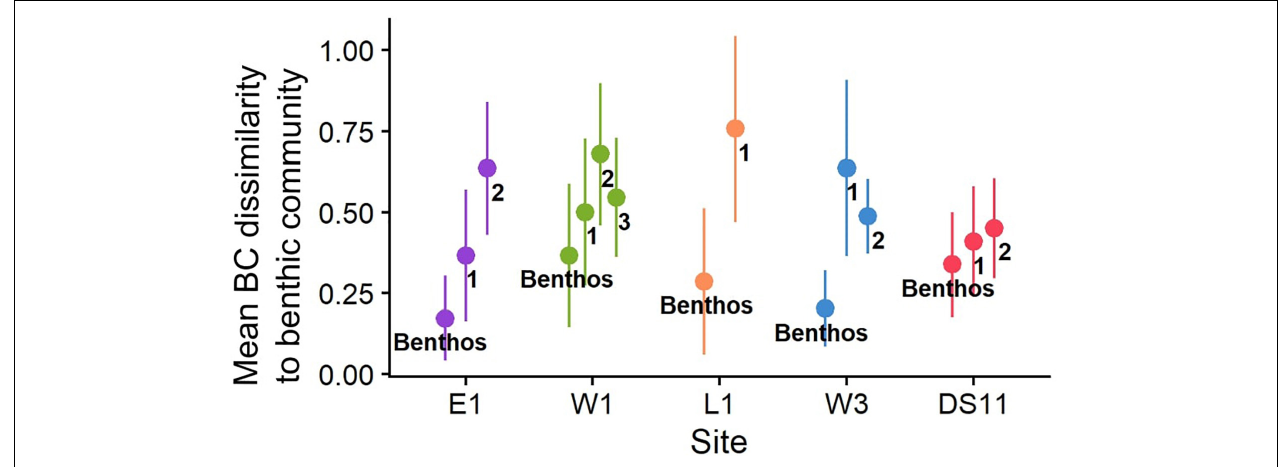
FIGURE 7 | Mean Bray-Curtis (BC) dissimilarity within the established benthic community (“Benthos”) and between the established benthic community and settlement tile communities (points numbered to represent deployment duration in years) as a function of site. For “Benthos” points, higher dissimilarity values reflect higher among-photoquadrat variability within the site. Higher dissimilarity values for numbered points represents higher mean pairwise group dissimilarity between the tile communities and the benthic community. Line ranges indicate SD. Sites are ordered by distance to river inputs ( Table 2 ).